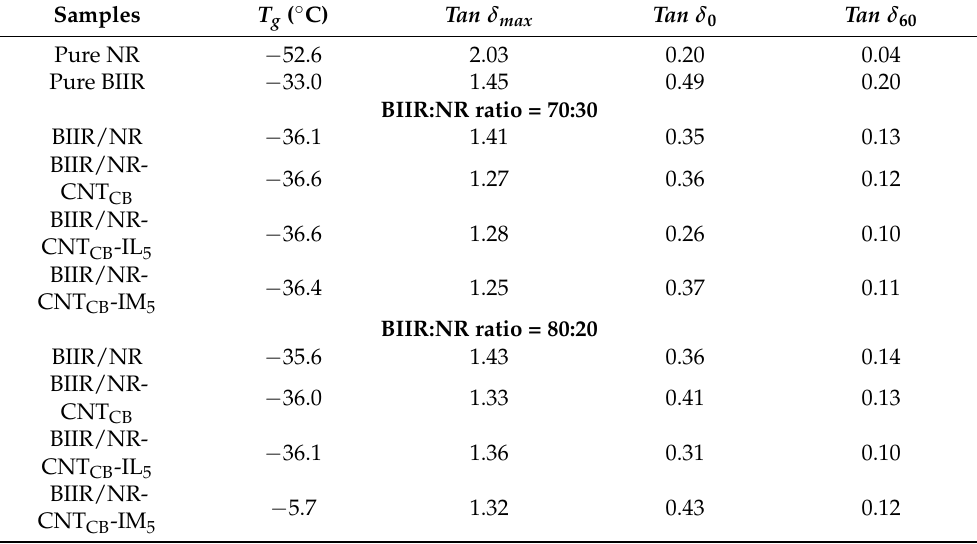
Table 5. Dynamic mechanical properties in terms of T g , Tan δ max , Tan δ 0 , and Tan δ 60 of the pure rubbers and their